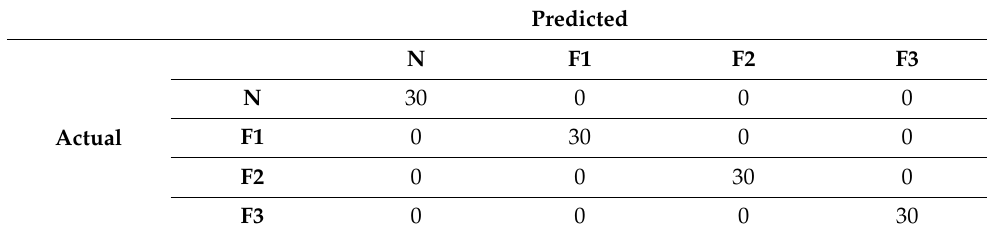
Table 3. Furnace: confusion matrix with the PA dataset, over unseen